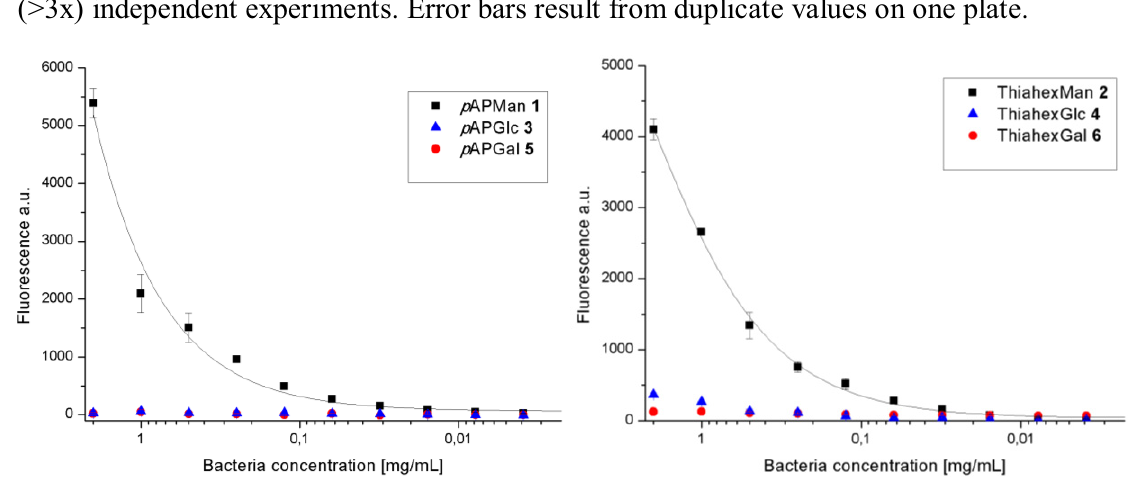
Figure 3. Bacterial binding to glycoarrays on microtiter plates with different bacteria concentrations. The depicted binding curves are representative examples from several (>3x) independent experiments. Error bars result from duplicate values on one